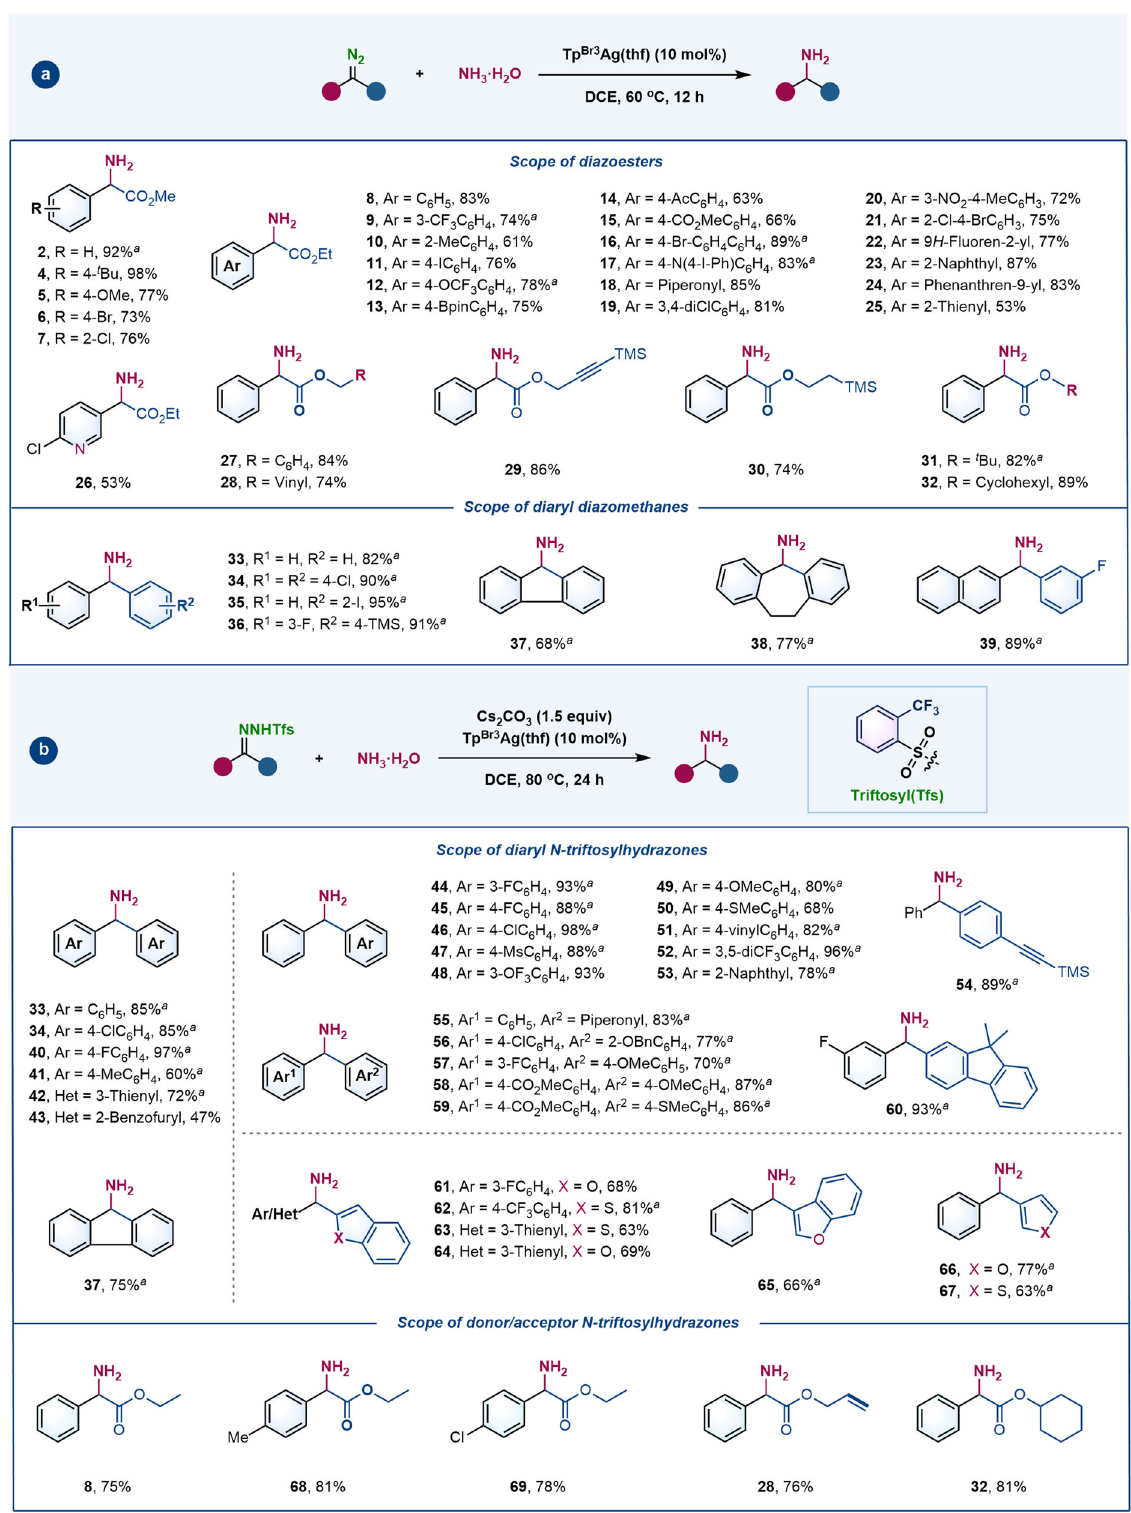
Fig. 2 | Reaction scope of carbene insertion into the N − H bonds of NH 3 ·H 2 O. a Silver-catalyzed N – H insertion of NH 3 ·H 2 O with diazo compounds. b Silver- catalyzed N – H insertion of NH 3 ·H 2 O with N -triftosylhydrazones. Reactions were